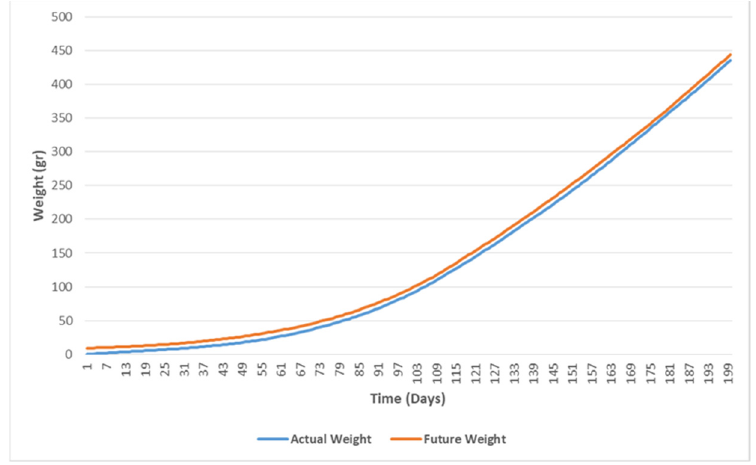
Figure 16. Fish weight adjustment.